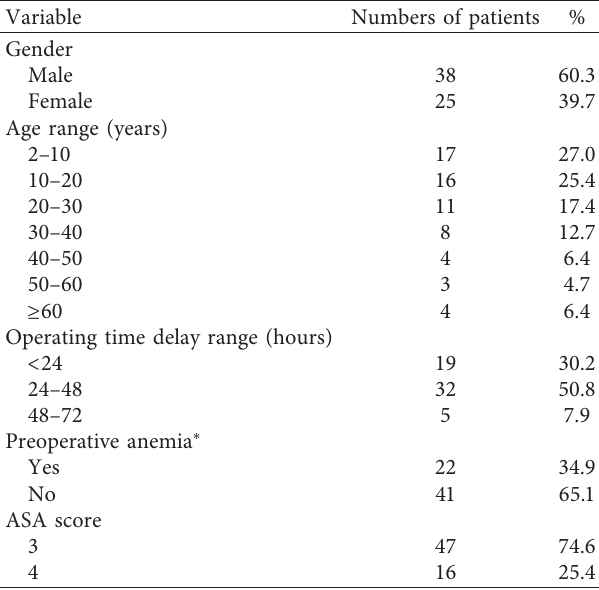
Table 1: Patients’ data.